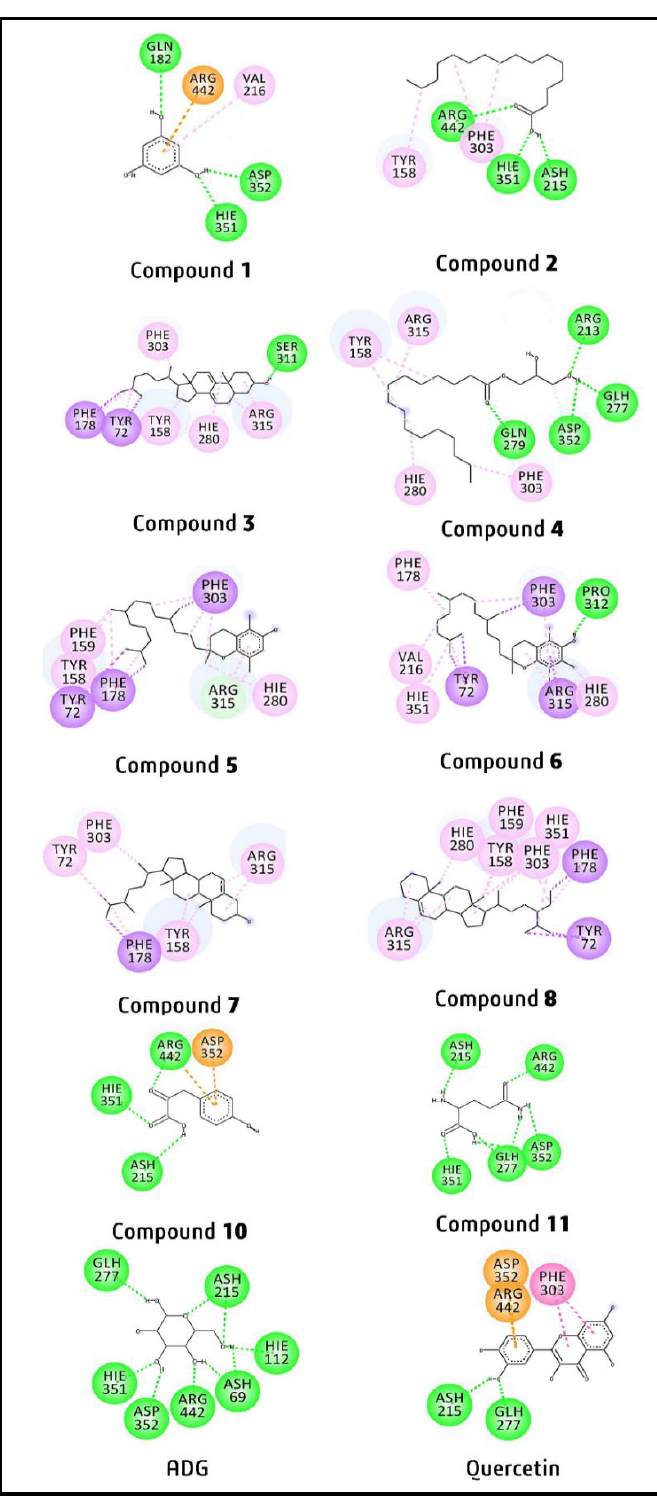
Figure 10. Predicted 2D binding interactions of the docked compounds 1 – 8 and 10 – 11 with α -glu- cosidase (3A4A). glucosidase